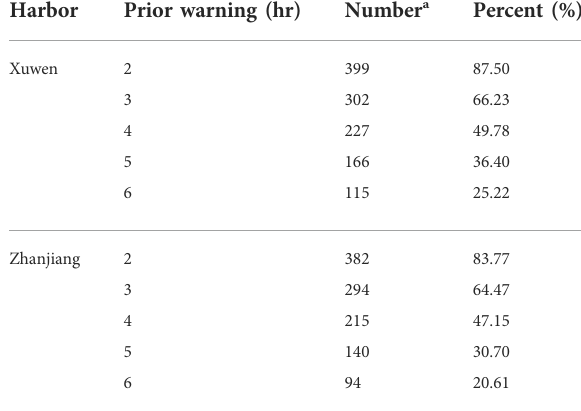
TABLE 4 Sea-fog detection